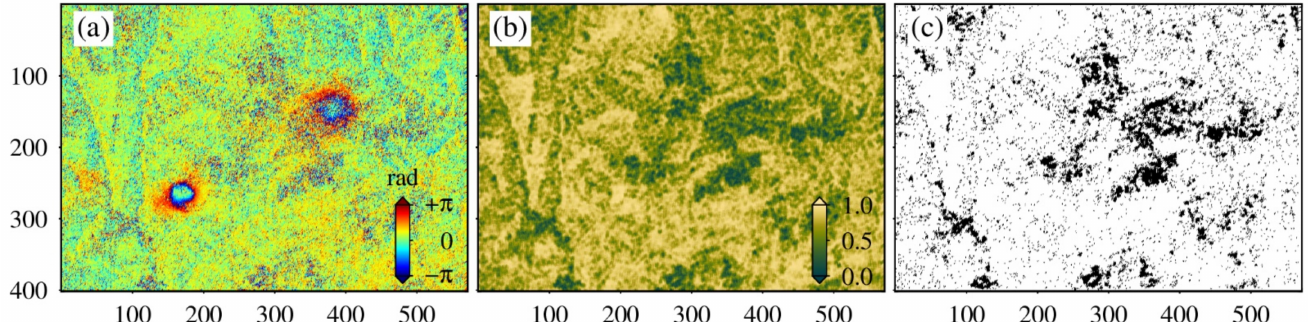
Figure 7. Data processing results in the Datong area of Shanxi Province. ( a ) Wrapped interferometric phase images, ( b ) interferometric coherence images, and ( c ) phase hierarchical results where white represents high-quality first-level phase points, and black represents low-quality second-level phase points.